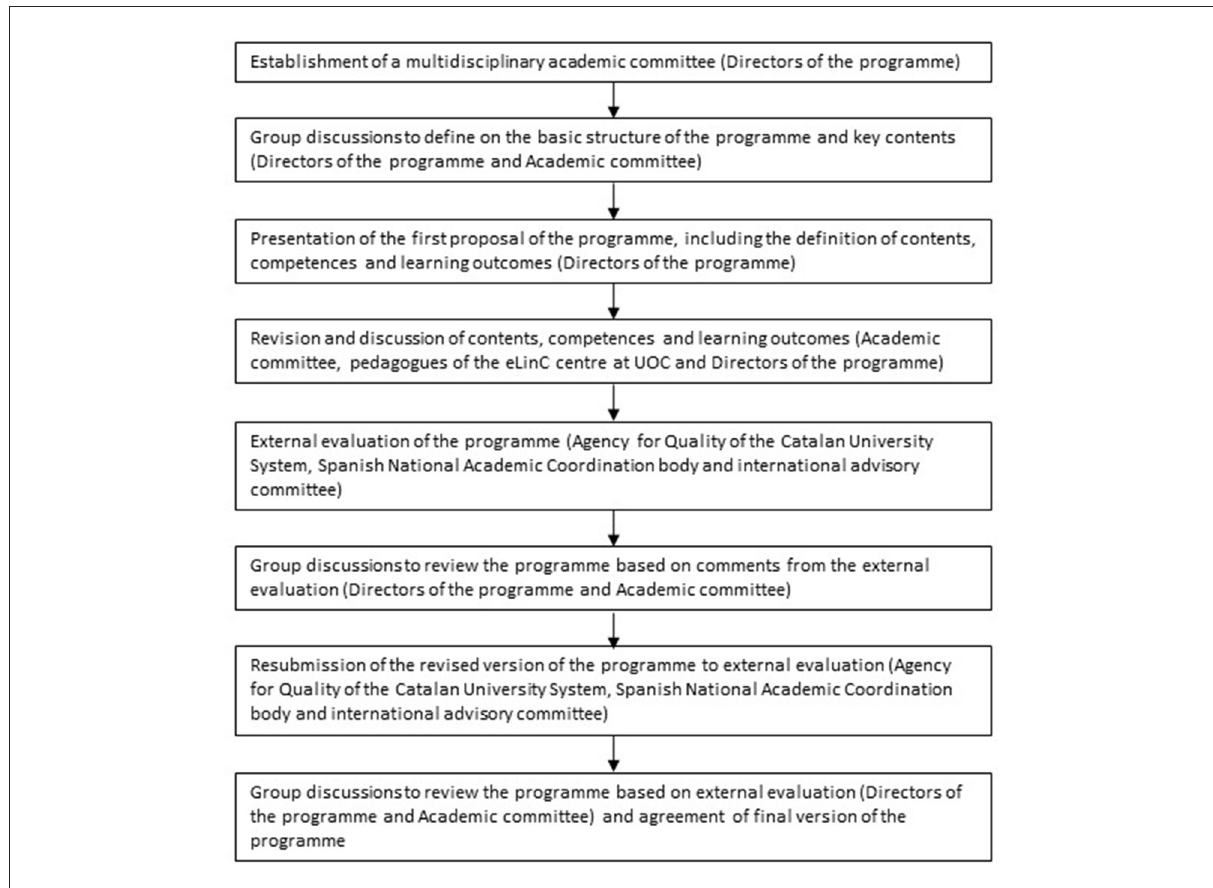
FIGURE2 Steps followed to define the programme and the actors involved in each